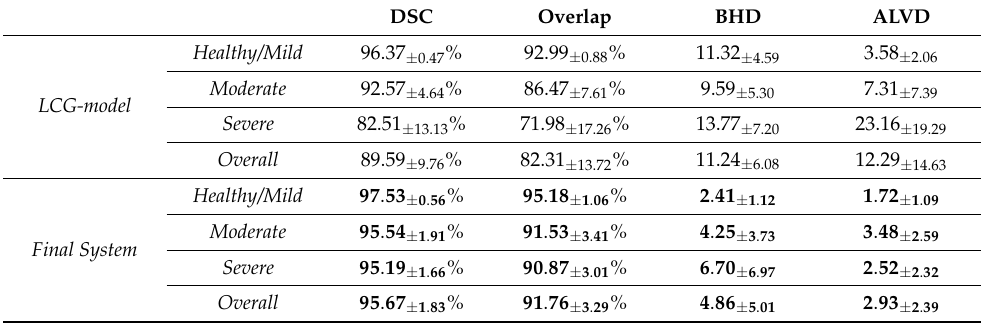
Figure 7. An illustrative example of the proposed appearance model estimated from Thin-Section CT appearance model for ( a ) healthy/mild, ( b ) moderate, and ( c ) severe COVID-19 infected lung. Note that first, second, and third rows represent empirical, marginal, and mixed densities, respectively. Table 2. Quantitative evaluation of the proposed segmentation system before and after applying rotation invariant Markov–Gibbs random field (MGRF). Note that LCG, DSC, BHD, and ALVD stand for linear combination of Gaussian, Dice similarity coefficient, 95th-percentile bidirectional Hausdorff distance, and absolute lung volume difference,